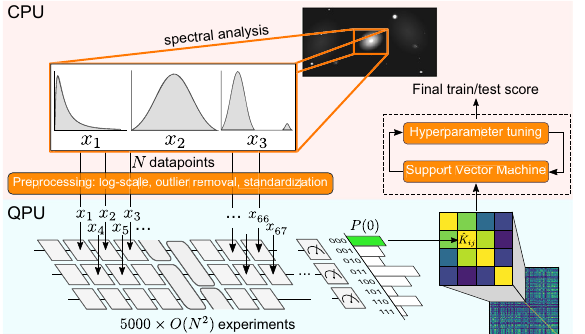
Fig. 1 Overview of quantum kernel SVM. In this experiment, we performed limited data preprocessing that is standard for state-of- the-art classical techniques, before using the quantum processor to estimate the kernel matrix ^ K ij for all pairs of encoded data points ( x i , x j ) in each dataset. We then passed the kernel matrix back to a classical computer to optimize an SVM using cross-validation and hyperparameter tuning before evaluating the SVM to produce a fi nal train/test score.